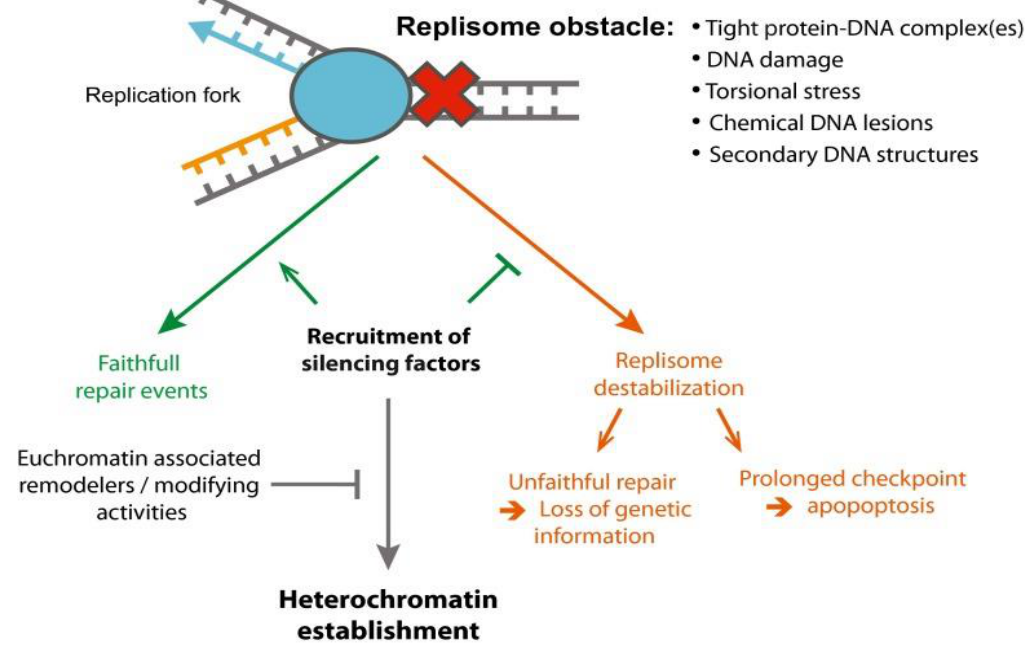
Figure 3. Heterochromatin formation during replication stress to prevent loss of genetic information Figure3. [171] .